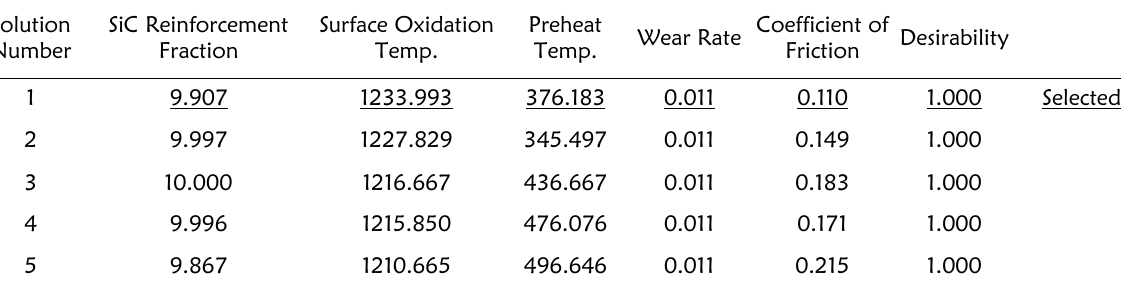
Table 9: Optimal solution generated for the